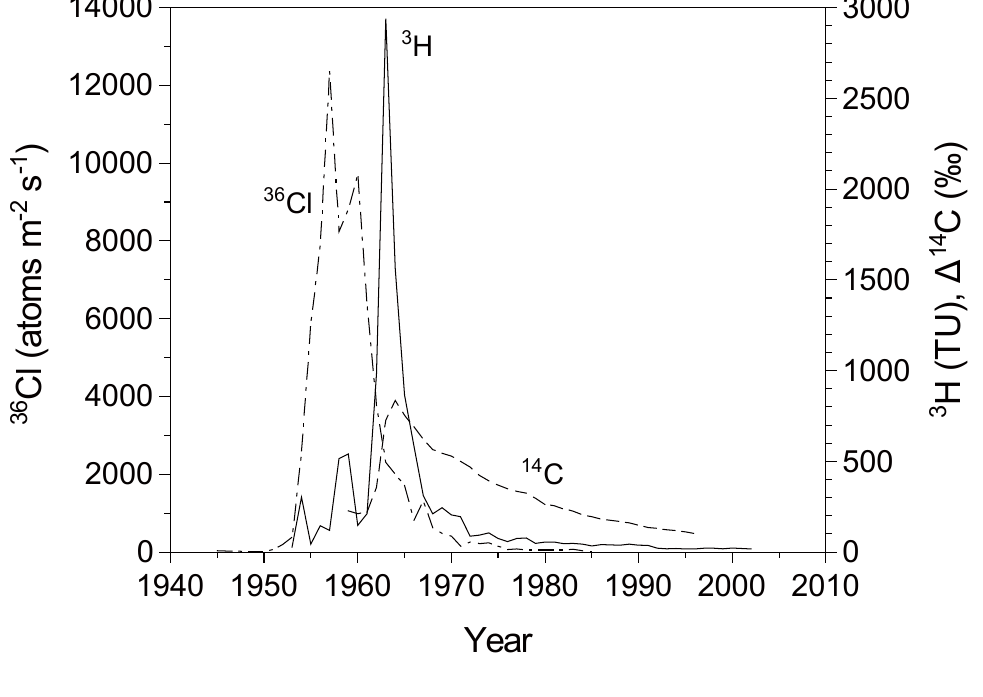
Figure 1. Atmospheric concentrations or fallout rates of bomb-derived environmental tracers (after [27]): 36 Cl fallout rates at the Dye-3 site, Greenland [11]; 3 H concentration in precipitation at Ottawa, Canada [28]; and atmospheric  14 C record at Vermunt, Austria (1959–1983); and Schauinsland, Germany (1984–1996)